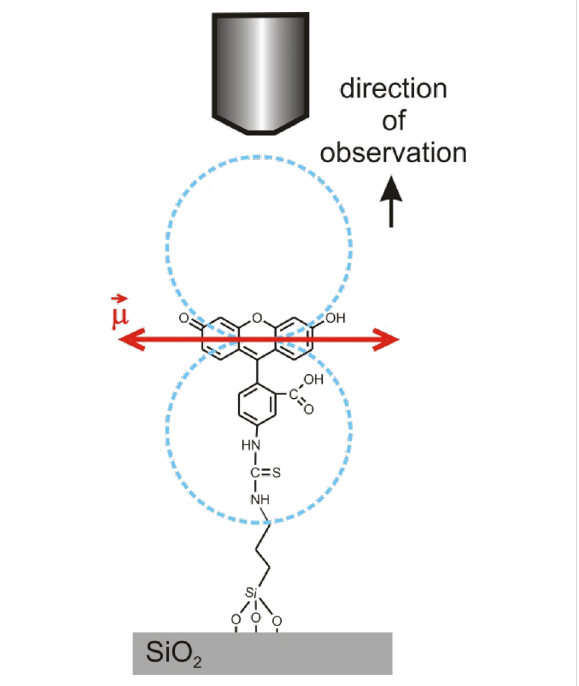
by comparison with the study of Imhof et al. [38]. They investi- gated FITC bound to silica spheres and found a quenching of the fluorescence intensity for increasing dye concentration, which was attributed to an interaction between neighboring molecules. This interaction also causes a lowering of the